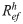
Estimation of Model SIR in Period 3 (October/2004– September/2008).(a) observed incidence (O) and adjusted i (E), (b) m3/m, (c) Refh (h) and Refm (m), and (d) Ref=Refh×Refm.